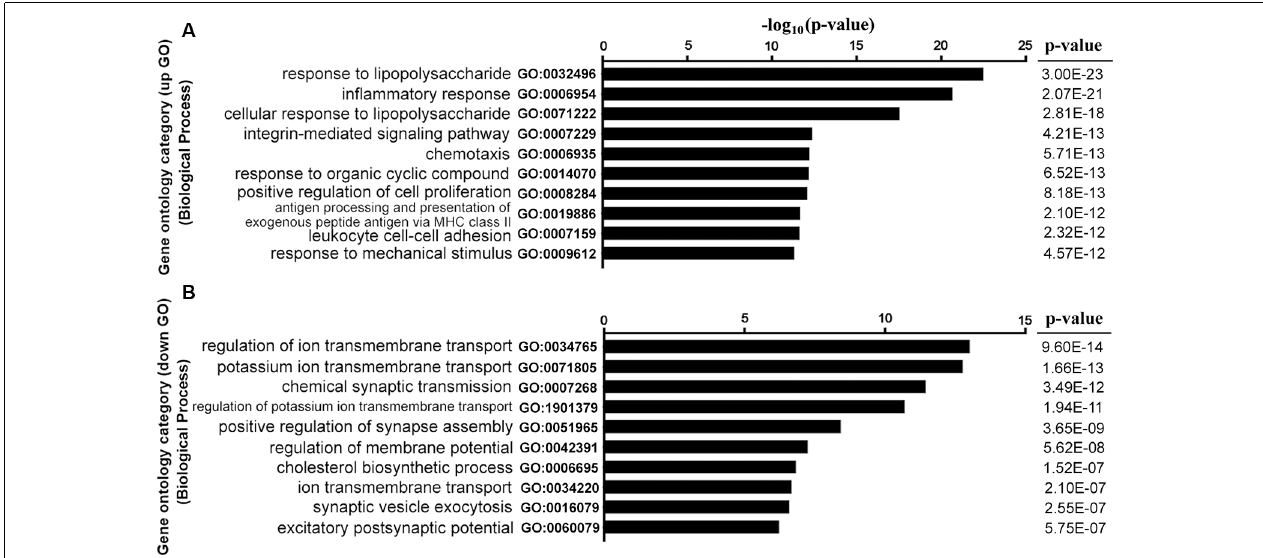
FIGURE 3 | Functional enrichment analysis for DEGs. GO terms enriched by upregulated (upGOs) and downregulated genes (downGOs) are shown as (A) and (B) , respectively. The horizontal axis represents the value of − log 10 ( p -value), and the vertical axis represents the category of GO biological processes. P -value was adjusted by FDR. GO, gene ontology. BP, biological process.